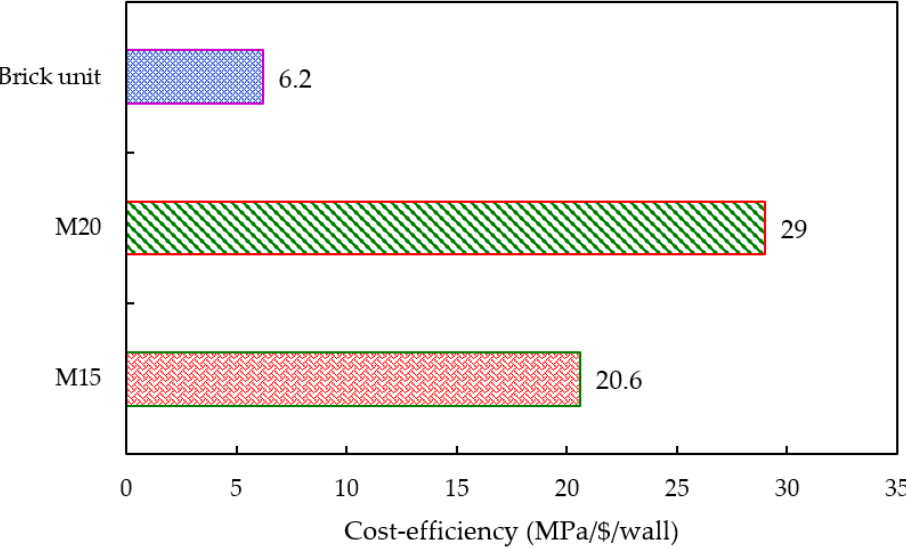
Figure 16. Cost-efficiency analysis of ICF and brick walls.